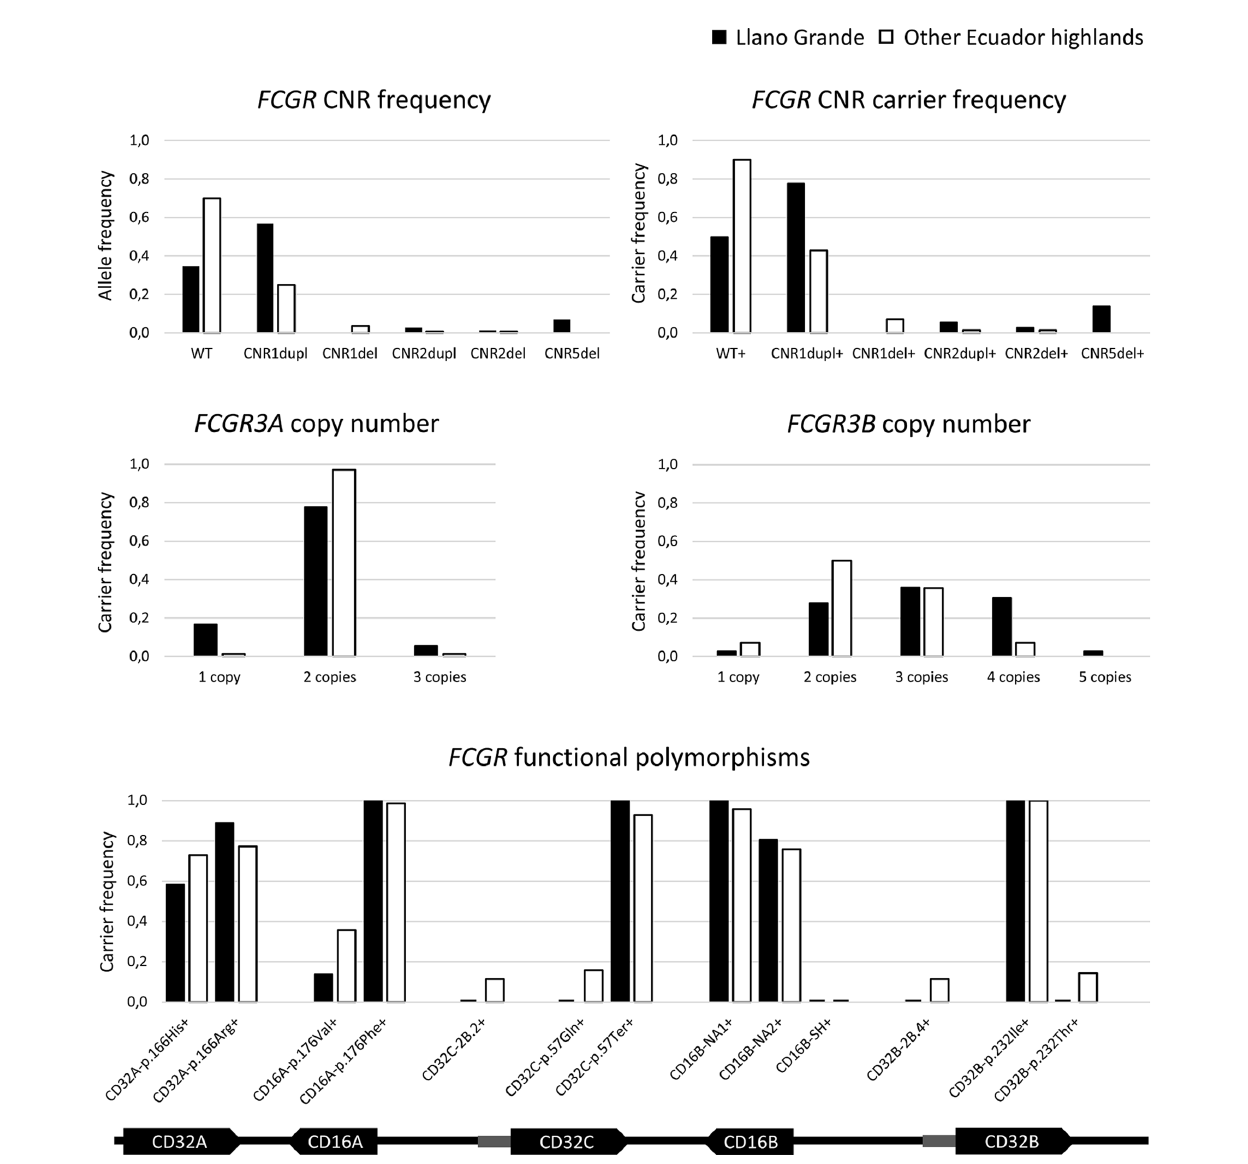
FIGURE 3 | FCGR genetic variation in highlands Ecuadorians. Additional details are provided in Supplementary Table 3 . Any putative CNR4 duplication is indistinguishable from and classi fi ed as CNR1 duplication, in agreement with all previous reports. Hypothetical rare combinations of CNR1 duplication on one chromosome and CNR1 deletion on the other one of the same donor are indistinguishable from and would have been classi fi ed as WT/WT. FCGR3B/A was included in neither FCGR3B nor FCGR3A